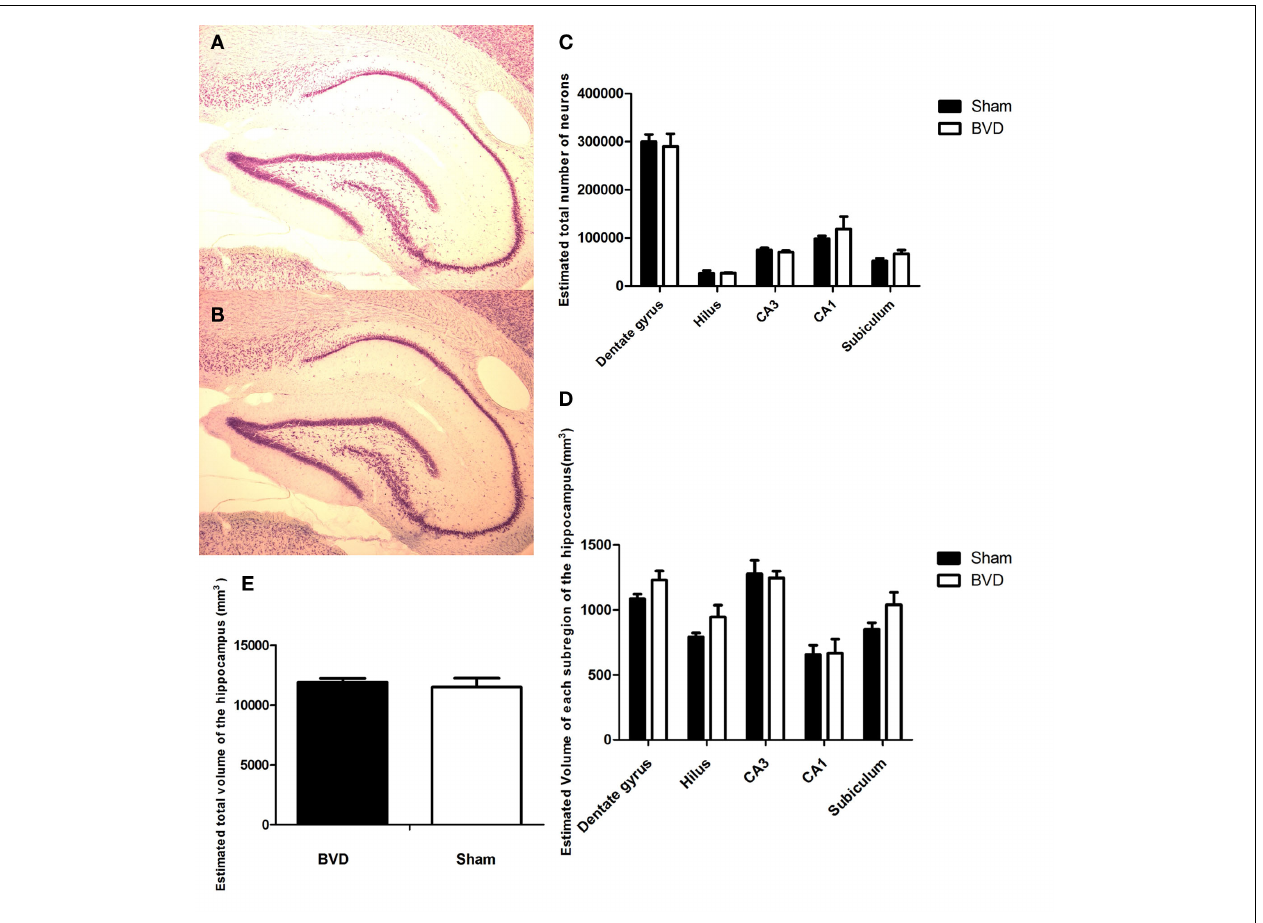
sham surgery. (D) Estimated volume (in cubic millimeter) of the subregions of the hippocampus in animals at 16months post-BVD or sham surgery. (E) Estimated total volume of the entire hippocampus (in cubic millimeter) in animals at 16months post-BVD or sham surgery. Bars show means + 1